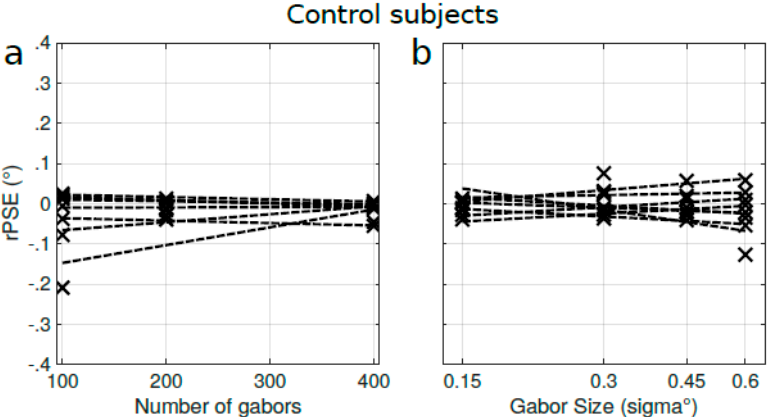
Figure A4. Effect of density and spatial frequency on control subjects. ( a ) rPSE as a function of the number of Gabor patches for eight control subjects. ( b ) rPSE as a function of the size of the Gabor patches for eight control subjects. Dashed lines represent linear regression.